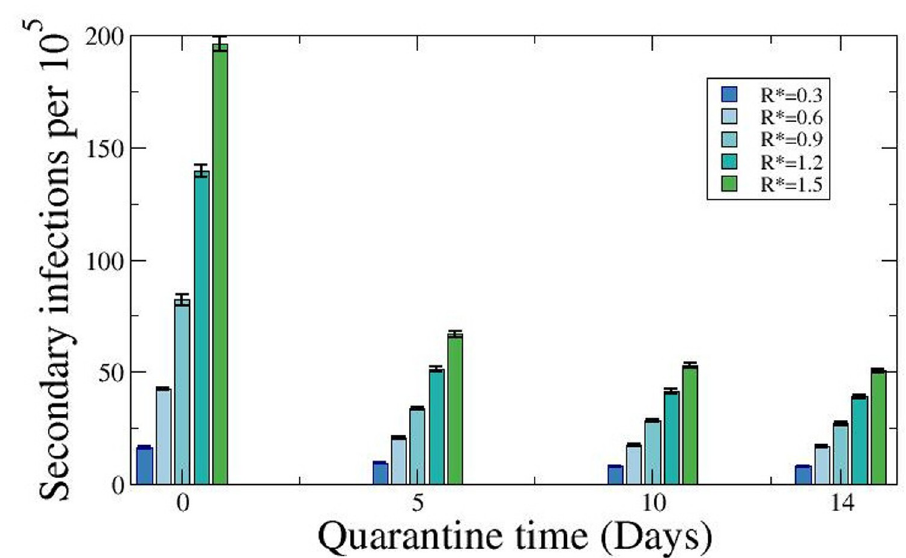
Fig 2. Variation of the number of secondary infections per 10,000 students according to the days of quarantine. Number of secondary cases obtained from the numerical simulations tuning the values of R � and varying the number of quarantine days after the detection of the first infected individual. Simulations done keeping A 14 = 250 cases per 10 5 inhabitants, and the total number of groups of 20 students fixed to 72,000 and therefore the total number of students fixed to